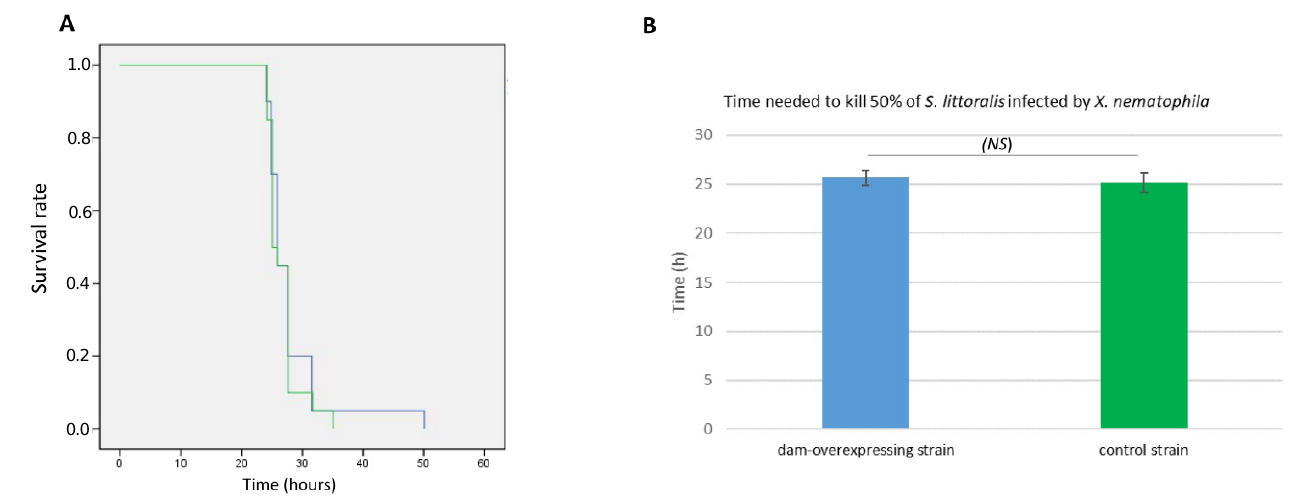
Figure 8. Infection of Spodoptera littoralis larvae by X. nematophila overexpressing dam and the control strain. ( A ) Proportion of survival of S. littoralis after injection of 10 4 CFU of X. nematophila overexpressing dam (blue) or carrying the vector control (pBBR1-MCS5, green). Presented results are from one experiment (with 20 insect larvae infected for each bacterial strain), representative of three independent experiments. ( B ) The histograms represent the mean values ( ± standard error to the mean) of the time needed to kill 50% of infected larvae (LT 50 ) monitored from 3 independent experiments. The LT 50 were not significantly different between the two strains (NS, p > 0.05, Student’s t -test).